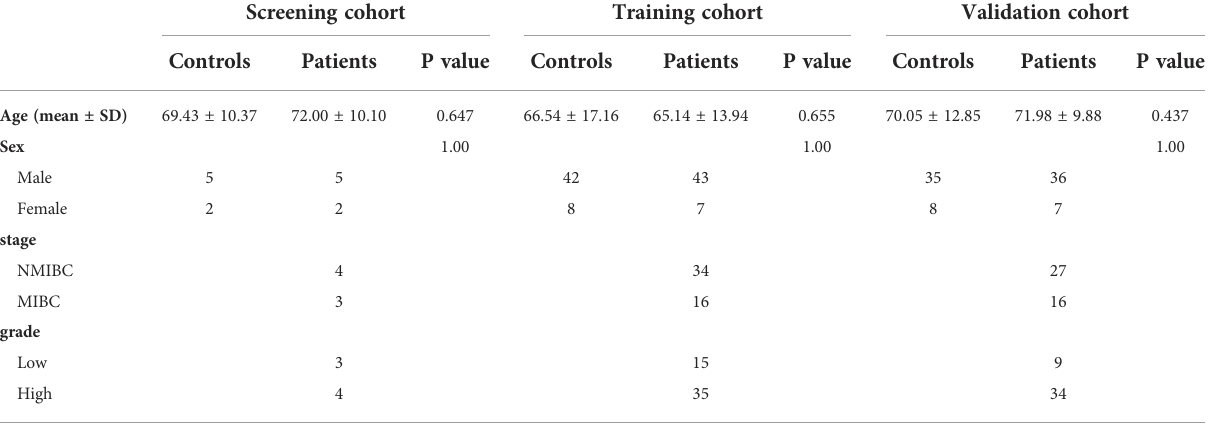
TABLE 1 Clinical characteristics of participants in screening, training and validation